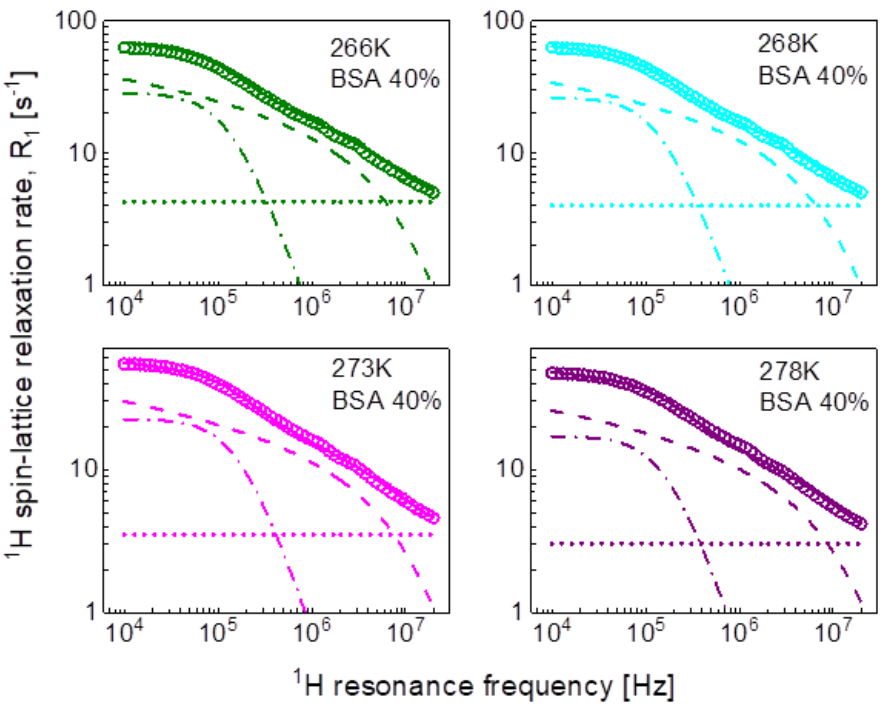
Figure 6. 1 H spin-lattice relaxation data for BSA–water mixture (40%wt of BSA) reproduced in terms of Equation (9); solid line—overall fit decomposed into a Lorentzian term (dashed-dotted line), a term associated with two-dimensional translation diffusion (dashed line) and a frequency independent term (dotted line). Following the line of two-dimensional translation diffusion, in the last step we have attempted to reproduce the relaxation data in terms of Equation (8) that includes the res- idence life time, 𝜏 𝑟𝑒𝑠 . It has turned out that this concept enables reproducing the relaxa- tion data for 20%wt and 40%wt of BSA with a contribution associated with two-dimen- sional translation diffusion dominating over a broad frequency range, as shown in Figure 7 and Figure 8, respectively. The obtained parameters are collated in Table 4.